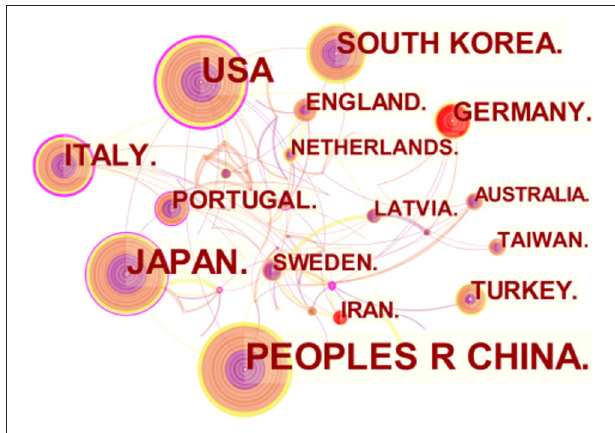
FIGURE 2 | Network of countries and regions engaged in AG